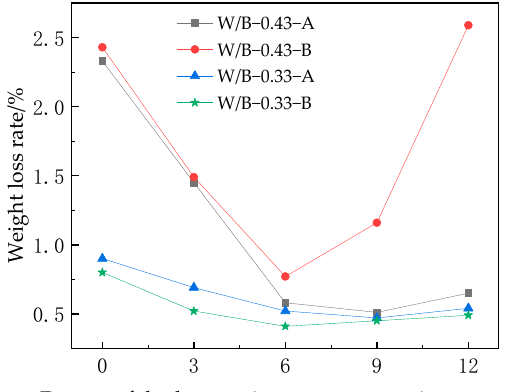
Figure 7. The resistance to chloride ion penetration. ( a ) W/B-0.43, ( b ) W/B-0.33.